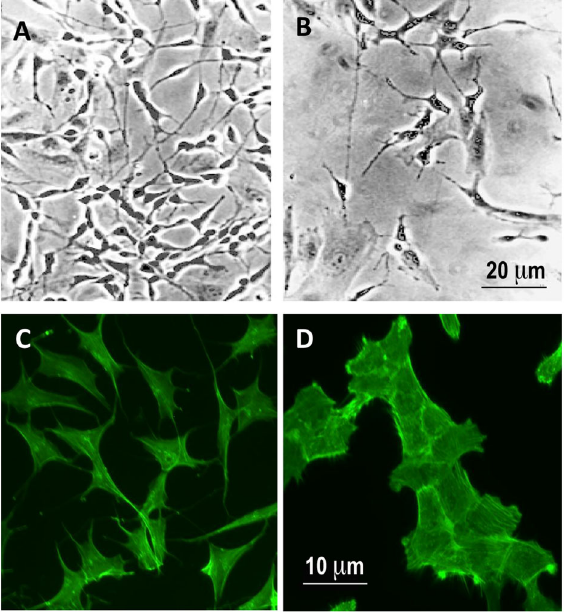
Figure 5. Exposure to 10 mM RU486 for 6 days induced a modi fi cation of the cell population toward a fi broblast-like phenotype. Phase contrast ( A and B ) and fl uorescein-phalloidin staining ( C and D ) of SK-N-SH cells treated for 6 days with vehicle (DMSO 0.1%; A and C ) and 10 mM RU486 ( B and D ). Magni fi cation bars: 20 m m ( A and B ) and 10 m m ( C and D